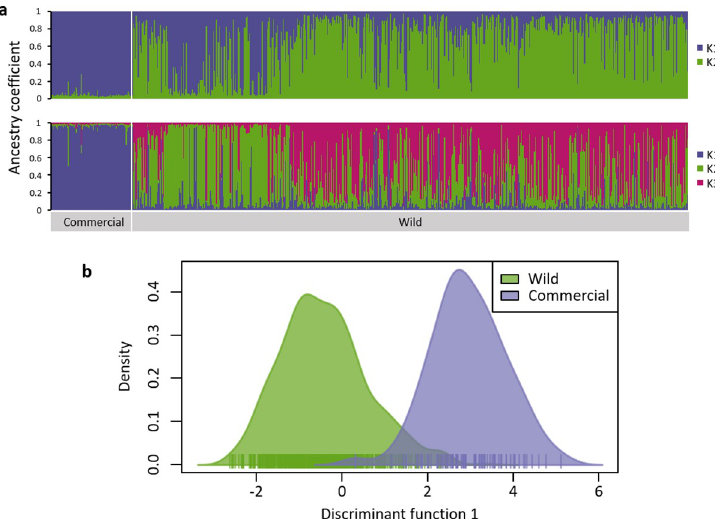
Fig 3. Genetic structure of Aphidius ervi based on seven microsatellite loci for all parasitoids (commercial and wild): (a) inference of population structure using Bayesian clustering with the program STRUCTURE (K = 2 and K = 3, the most probable numbers of clusters are presented, coefficient of ancestry is an average on ten runs) and (b) Discriminant Analysis of Principal Components according to the origin of the parasitoids (wild or commercial). https://doi.org/10.1371/journal.pone.0249893.g003 southern regions ( Fig 5B ). The percentages of assignment to the region of origin were 88% for ‘Southeast’, 97% for ‘Southwest’, 94% for ‘West’ and 93% for ‘Center’. Finally, among pairs of aphid hosts within ‘ Fragaria ’, differentiation was very low (F : ST from 0.012 to 0.014, D: from 0.011 to 0.027) and significantly different from zero only between ‘ R . porosum ’ and ‘ M . euphorbiae ’. A similar proportion of individuals emerging from each spe- cies was assigned to K1 (47 to 52%) and to K2 (32 to 38%; Fig 6B ). DAPC showed Fragaria Fragaria